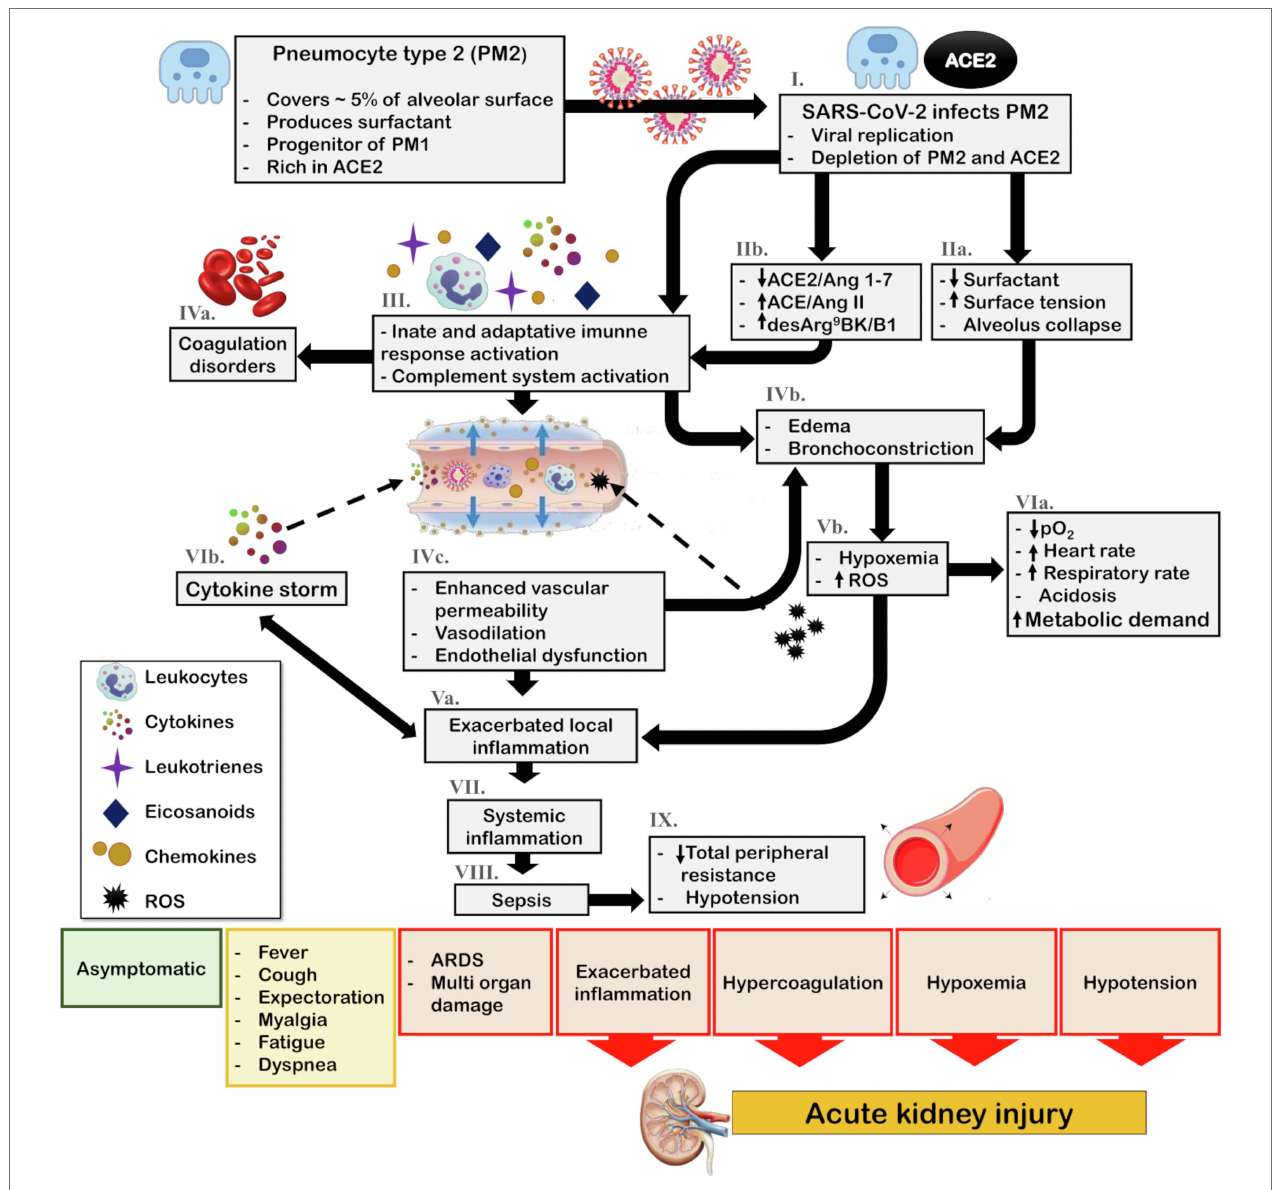
FIGURE 3 | Schematic representation of COVID-19 pathophysiology and its indirect effects on kidney. The main target of SARS-CoV-2 in the lungs is PM2. (I.) Viral infection and replication can culminate the depletion of PM2 and ACE2 reservoir. Consequently, (IIa.) surfactant production diminishes, leading to an increase in surface tension and alveolar collapse. Additionally, (IIb.) SARS-CoV-2 infection associated with ACE2/Ang 1–7 downregulation and ACE/Ang II and desArg 9 BK/B1 exacerbation promotes the (III.) activation of the innate and adaptative immune response and complement system leading to recruitment of leukocytes and release of cytokines, chemokines, eicosanoids, and leukotrienes. The complement system and eicosanoids promote (IVa.) coagulation disorders and the leukotrienes in association with increased surface tension contribute to (IVb.) bronchoconstriction. Moreover, the local inflammation culminates in (IVc.) increased vascular permeability, vasodilation, and endothelial dysfunction, thereby enhancing leukocyte recruitment, and leading to (Va.) exacerbated local inflammation what also contribute to (IVb.) bronchoconstriction and edema. Furthermore, bronchoconstriction and edema lead to (Vb.) hypoxia and ROS generation, which contributes to (VIa.) cardiorespiratory alterations that increase metabolic demand. Most importantly, ROS generation feeds the cycle of (Va.) enhanced inflammation. This inflammatory state leads to the (VIb.) cytokine storm and due to (IVc.) enhanced vascular permeability, viral particles, leukocytes, ROS, and cytokines can reach the blood stream, ultimately causing (VII.) systemic inflammation, (VIII.) sepsis, and consequently (IX.) hypotension. Depending on the patient health status, the steps in the pathophysiological cascade that are activated, and the intensity of the immune response, the clinical manifestations can vary from asymptomatic and mild symptoms, such as fever, cough, and myalgia, to severe symptoms, including acute respiratory distress and multi-organ damage. In this scenario, exacerbated inflammation, coagulation disorders, hypoxemia, and hypotension contribute to acute kidney injury (AKI). ACE, angiotensin-converting enzyme; ACE2, angiotensin- converting enzyme 2; Ang 1–7, angiotensin 1–7; Ang II, angiotensin II; B1, kinin receptor type 1; COVID-19, coronavirus disease 2019; desArg 9 BK, desArg 9 bradykinin; PM1, pneumocytes type I; PM2, pneumocytes type II; ROS, reactive oxygen species; and SARS-CoV-2, severe acute respiratory syndrome coronavirus